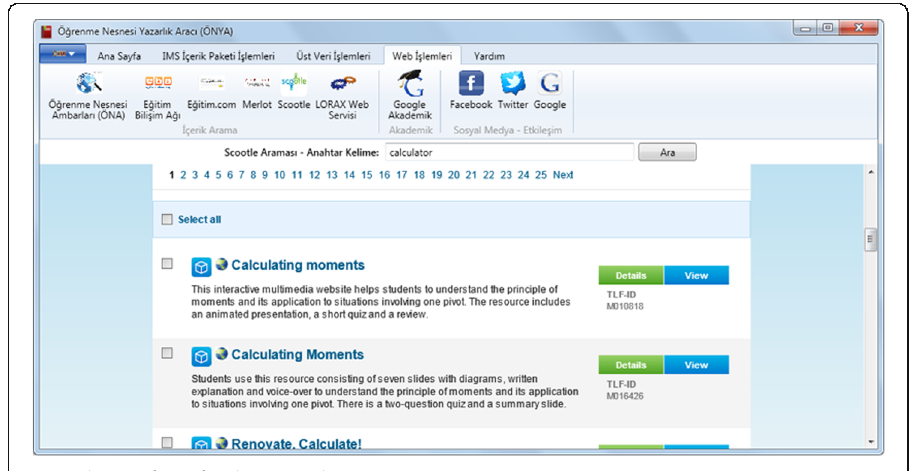
Fig. 2 The interface of authoring tool-ONYA